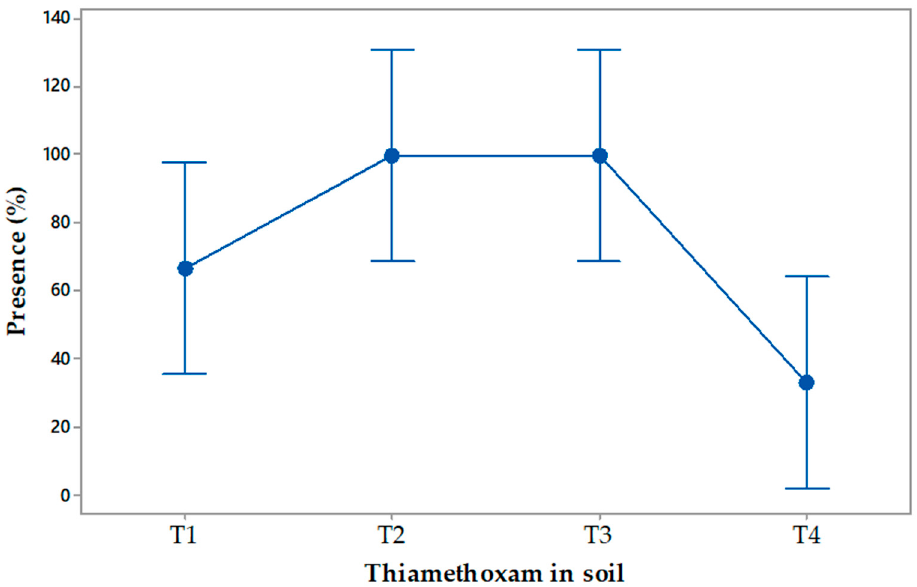
Figure 6. Presence percentage of thiamethoxam in soil in the papaya crop rotation with watermelon in an experimental plot. T4 presented significant statistical differences ( p < 0.05) with respect to T2 and T3, these differences were not evident with T1.